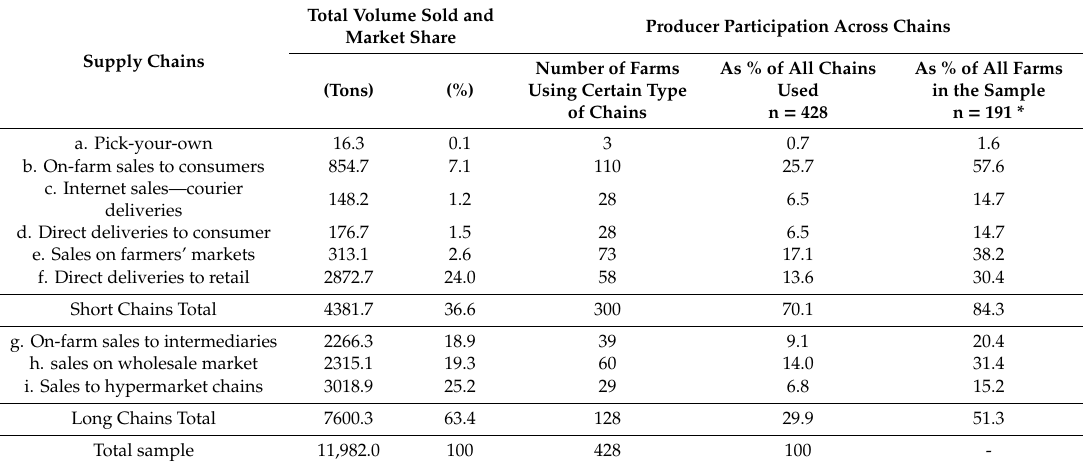
Table 4. Yearly sales by supply chain for the full